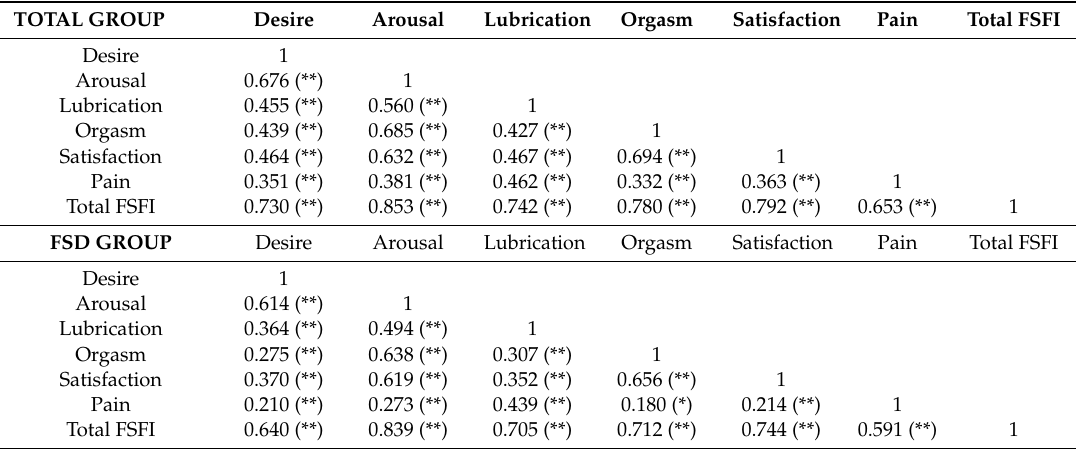
Table 5. FSFI Domains intercorrelations (Pearson